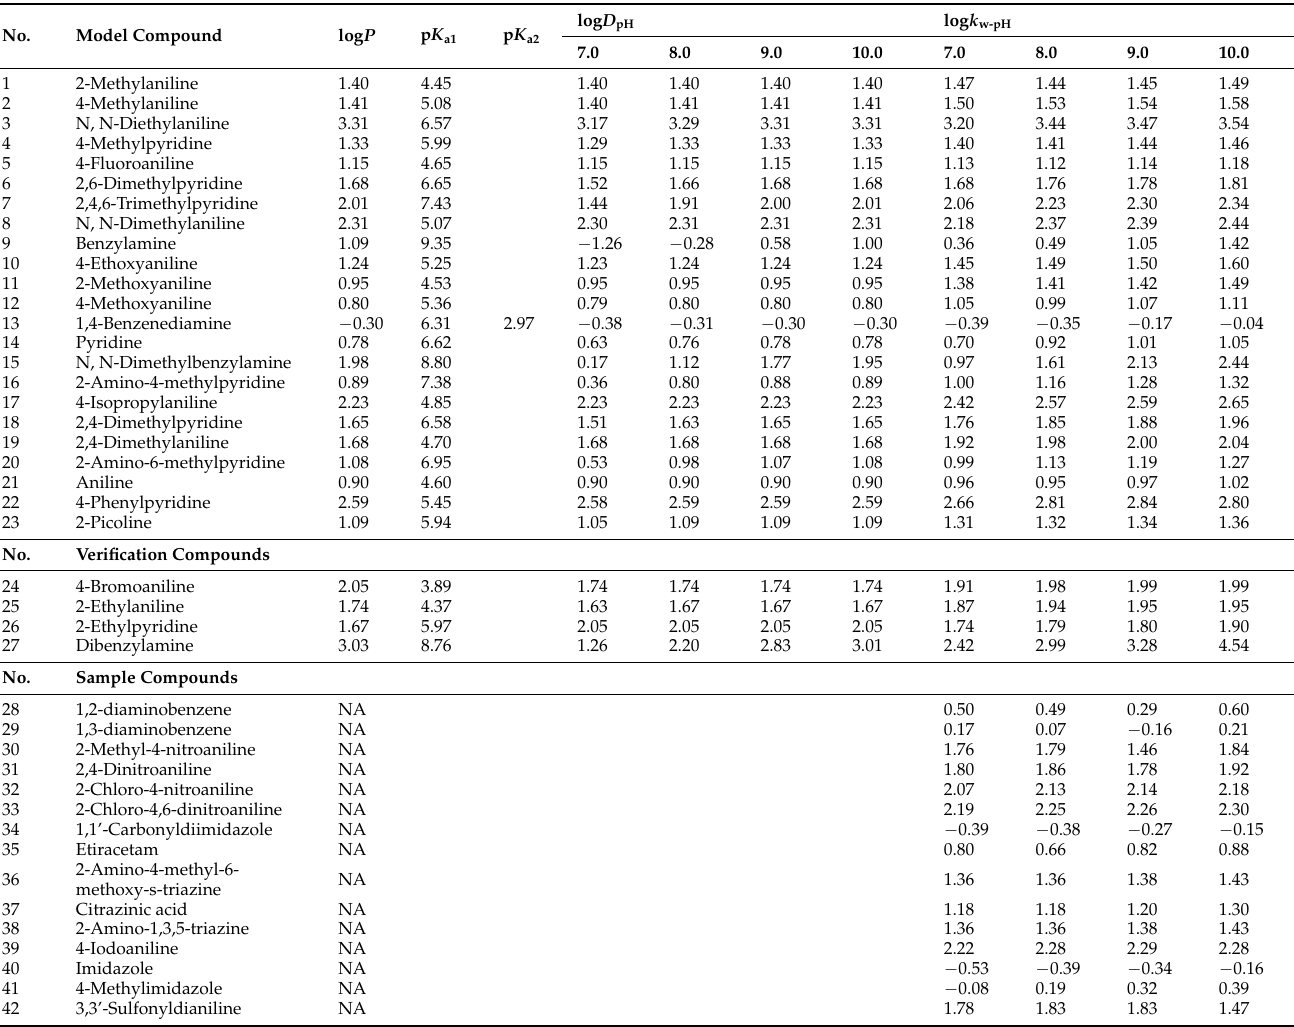
Table 1. The log D values of the model compounds and verification compounds calculated using Equation (S3) based on the log P and pH values are also listed in Table 1. Table 1. The log P and p K a values of each of the investigated compounds, as reported in the literature, as well as the corresponding log D values and the determined log k w